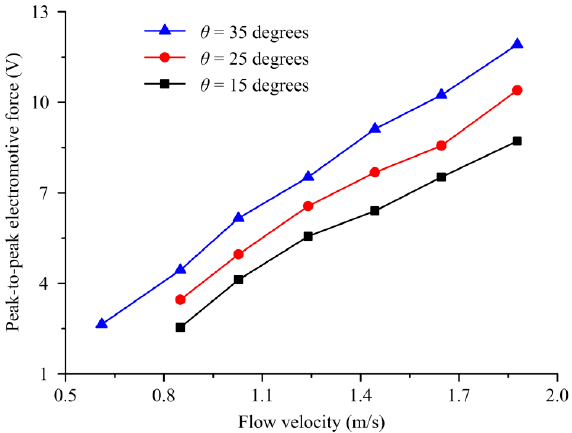
Figure 9. Induced electromotive force of prototypes with different groove angles under no-load condition.